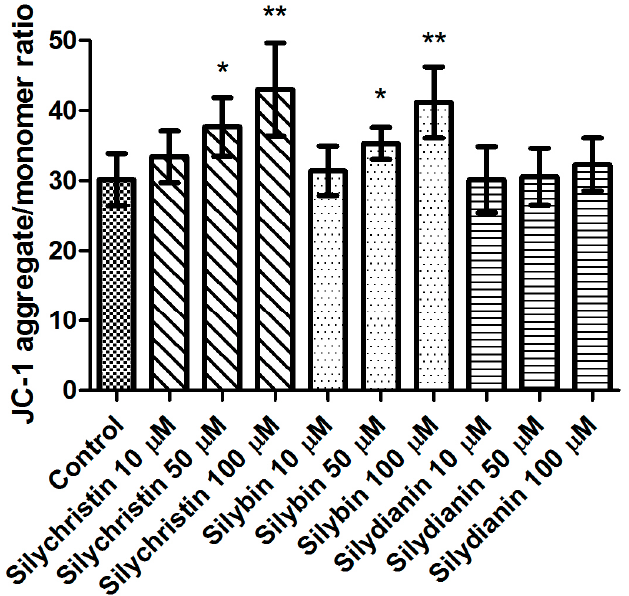
Figure 1. The effect of flavonolignans (silychristin, silybin and silydianin in concentrations of 10, 50 and 100 µM) on blood platelet mitochondrial membrane potential. MMP is expressed as a ratio of 530 nm/590 nm to 485 nm/538 nm (aggregates to monomer) fluorescence, as quantified with a fluorescent plate reader after JC-1 staining. The data represent means of ± standard deviation (SD), n = 12, * p < 0.05, ** p < 0.001.